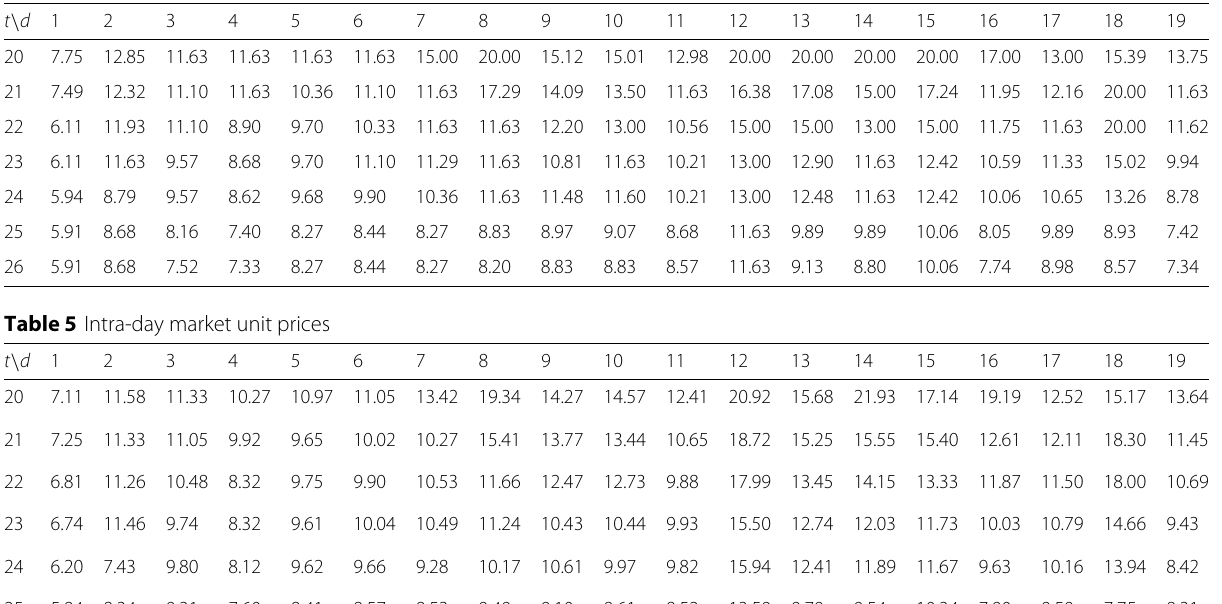
Table 4 Day-ahead market unit prices